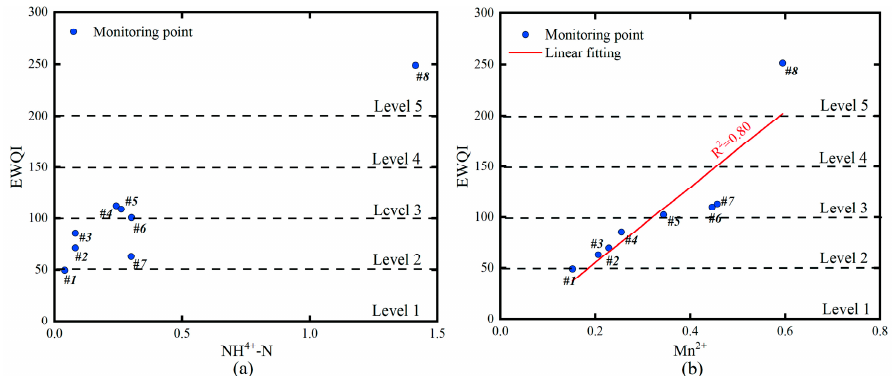
Figure 5. Groundwater NH 4+ -N and Mn v. EWQI scatter plots. ( a ) Scatterplot of NH 4+ -N EWQI levels in groundwater; ( b ) Scatterplot of Mn EWQI levels in groundwater.